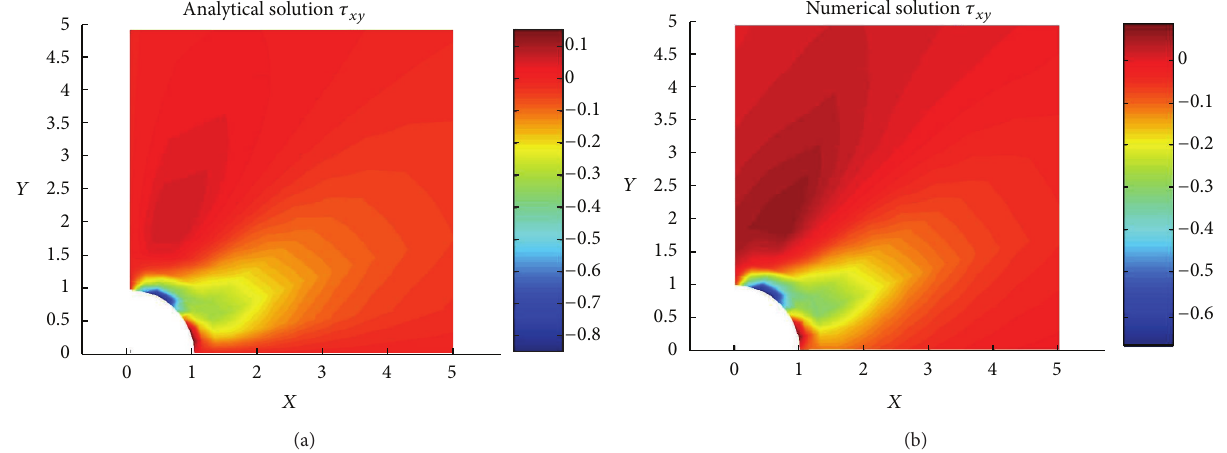
Figure 14: Shear stress 𝜏 𝑥𝑦 : analytical results (a) and RGD numerical results (b).